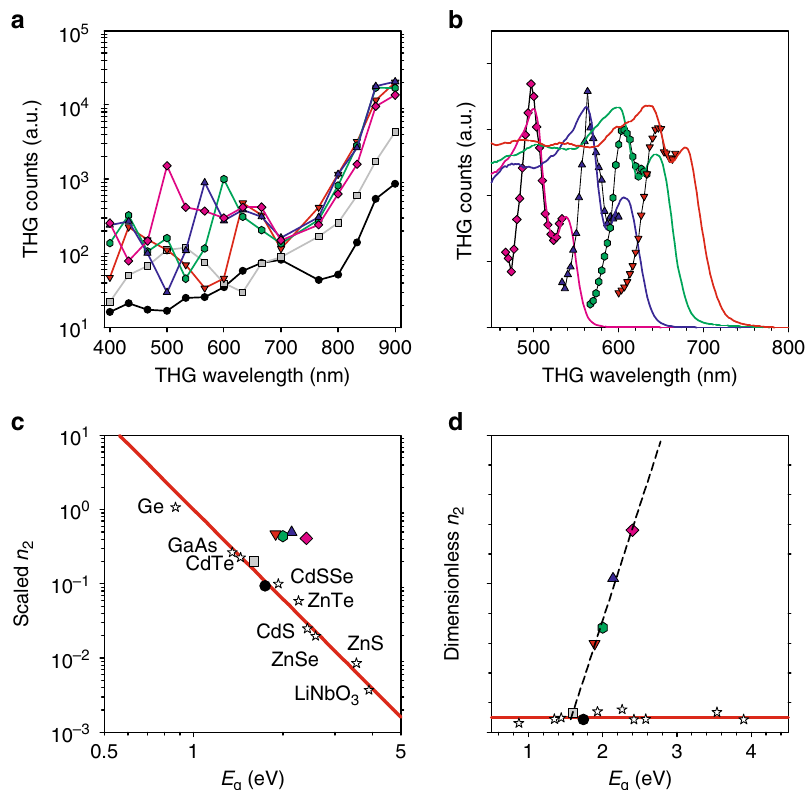
Fig. 2 Wavelength-dependent third harmonic generation and n 2 vs. bandgap. a Semi-log plot of broadband third harmonic generation (THG) comparison of n = 1 ( purple ), n = 2 ( blue ), n = 3 ( green ), n = 4 ( red ), n = ∞ ( grey ), and AgGaSe 2 ( black ). Data points are connected by the lines as a guide to the eye. b Fine- scale THG spectra scanned across the band edges of the 2D perovskites, overlaid with the measured absorption spectra ( colored traces ). c Log – log plot of ffiffiffiffiffi p THG coef fi cients in terms of the scaled nonlinear refractive index, 80 π 2 n 2 n 0 = ð Khc 2 E 0 G 2 Þ , vs. bandgap generated with the experimentally determined K = 3100. The red line is E (cid:2) 4 . THG coef fi cients of the 2D perovskites ( n = 1 – 4) are very large as evidenced by deviation from the two-band model ( red line ) and g exemplary performance in comparison to other inorganic semiconductors ( stars ). d Impact of quantum con fi nement on n 2 of the 2D perovskites. The two- band model ( red line ) successfully predicts the actual n 2 values of conventional 3D materials ( stars ) as well as the reference 3D materials ( grey square and ffiffiffiffiffi p black dot ). However, the strong deviation of the 2D perovskites from the theory is remarkable ( dashed line ), which shows the progressive increase in E 0 , which re fl ects the dipole matrix element between the valence and conduction bands